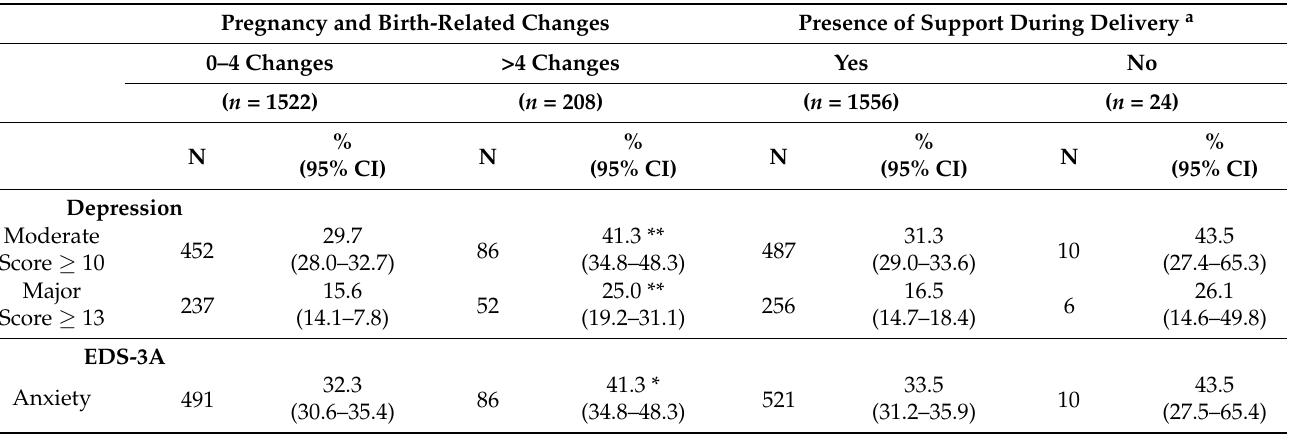
Table 3. Number and percentage of women scoring above the cut-off for symptoms of depression and anxiety, by (i) pregnancy and birth-related changes and (ii) presence of support at delivery. Pregnancy and Birth-Related Changes Presence of Support During Delivery